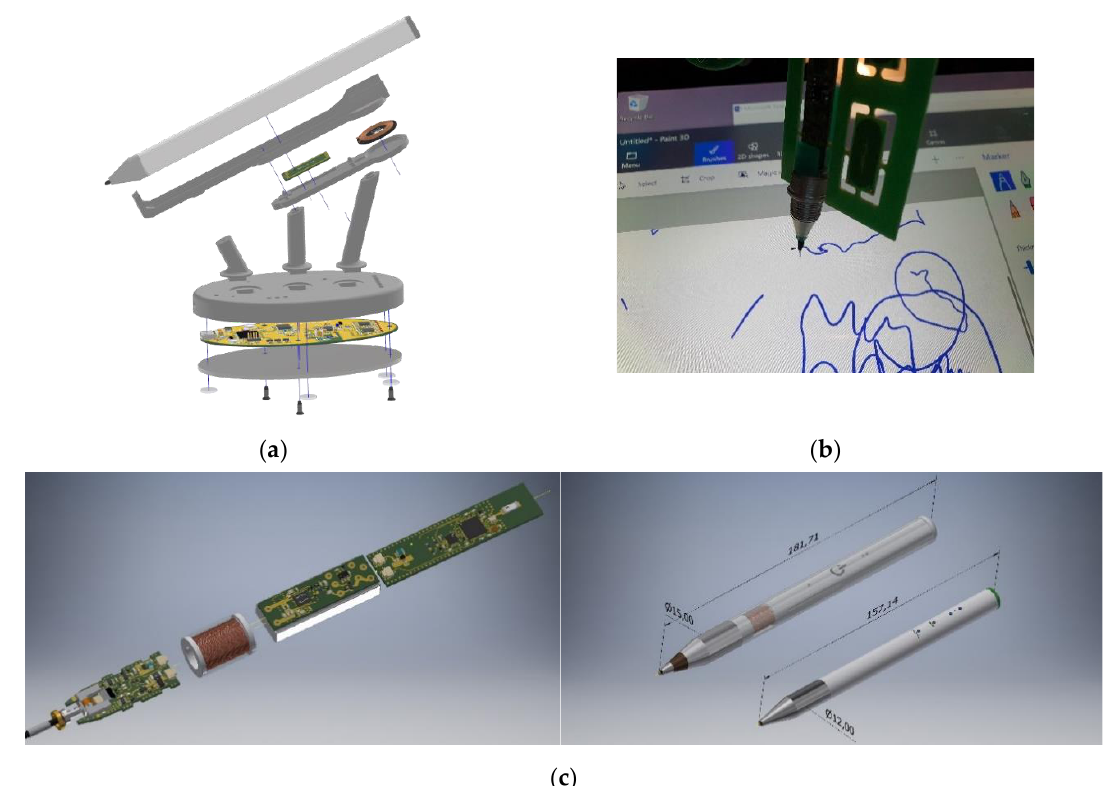
Figure 2. Construction details of the pen and its wireless charger ( a ); the pen prototype while interacting with a tablet screen ( b ); developed biometric pen for data handwritten signature recognition ( c ).